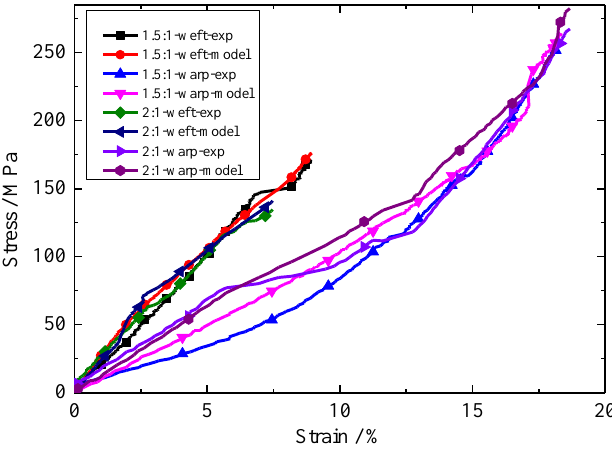
Figure 10. Comparison of test results and numerical models under different stress ratios.